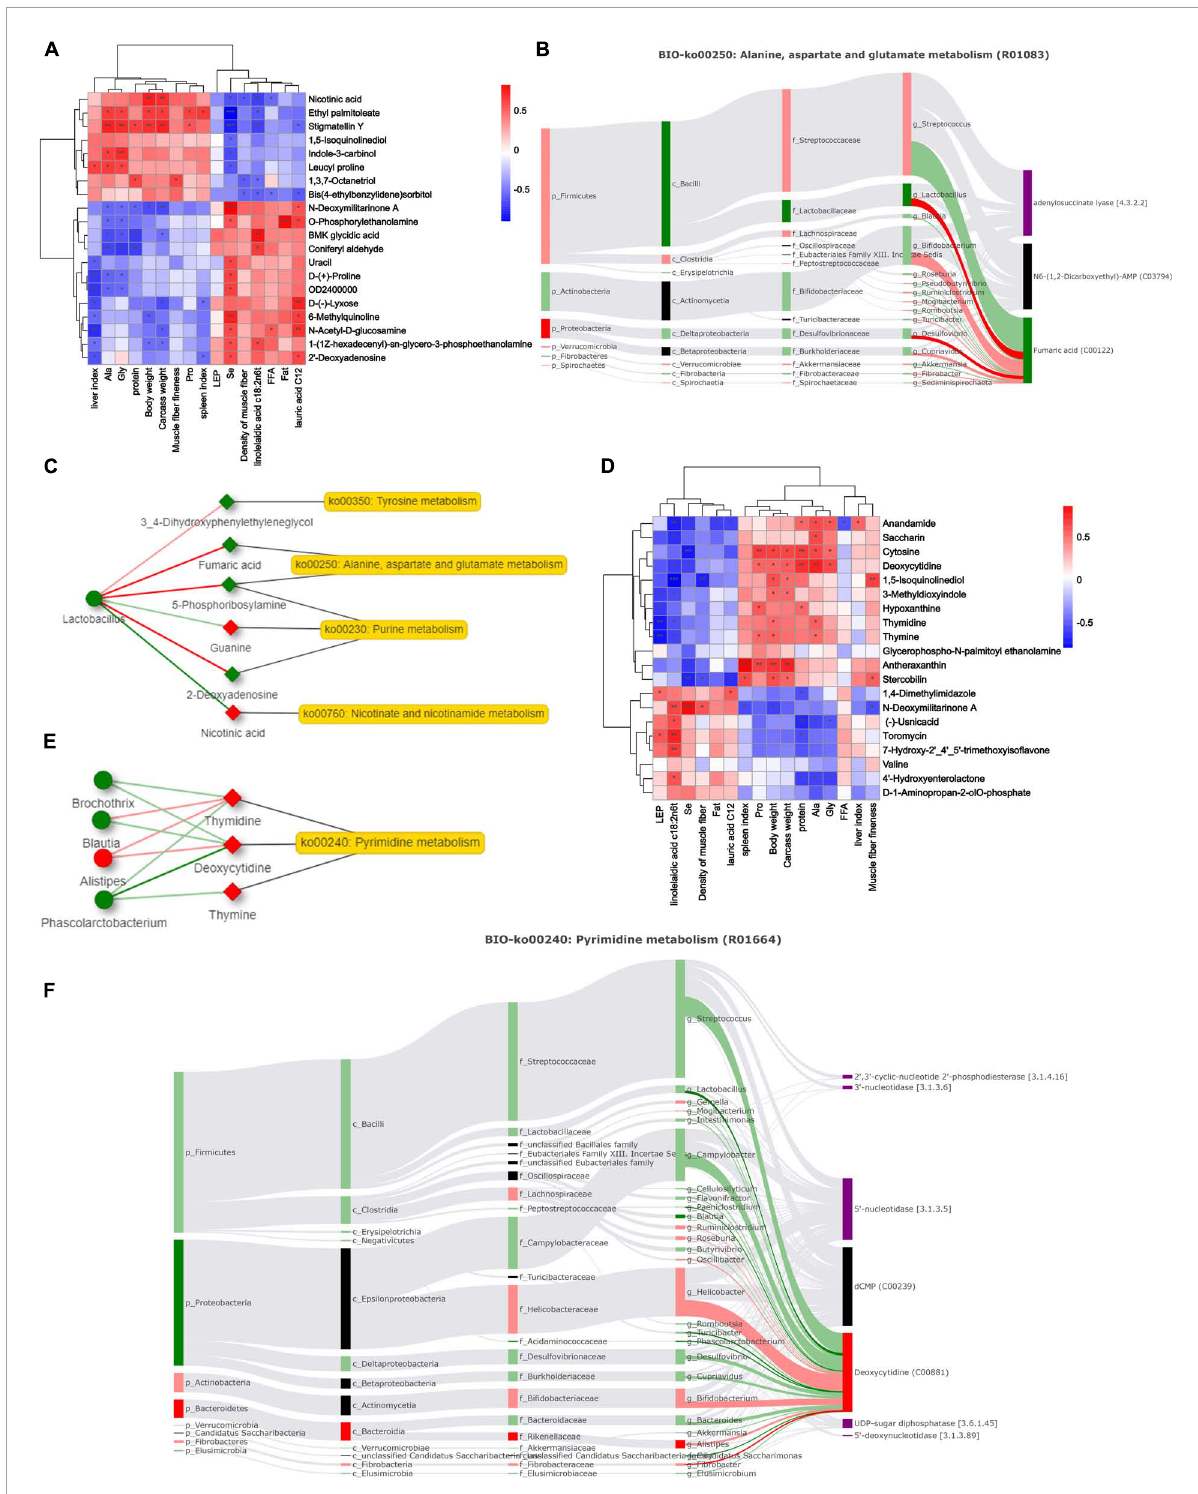
FIGURE7 Correlation analysis of microbes, metabolites and phenotypes. (A,D) Differential phenotypes among breeds and Spearman correlations of rumen and hindgut metabolites (* P- value < 0.05, ** P- value < 0.01, *** P- value < 0.001). (B,F) Biologically relevant sankey diagrams of microorganisms and metabolites in rumen and hindgut. Red indicates high expression in Dorper sheep, and green indicates high expression in Tan sheep ( P- value < 0.05). The light-colored line indicates that the spearman correlation is not significant ( P- value > 0.05), and the dark line indicates that the spearman correlation is significant ( P- value < 0.05). (C,E) Network analysis of key microbiota and metabolites in rumen and